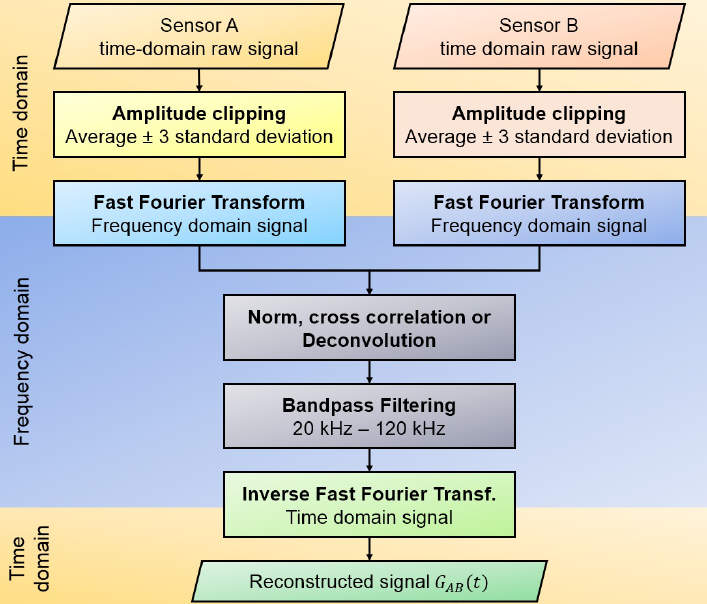
Figure 14. Signal processing steps accomplished in the passive reconstruction of the transfer function G AB ( ω )